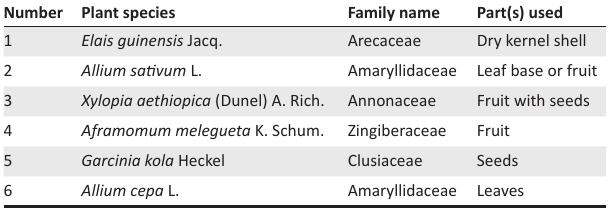
TABLE 3: Names of plants and their parts used for the formulation of traditional oral powdered herbal formulations for the treatment of arthritis or rheumatism in Ogbomoso,